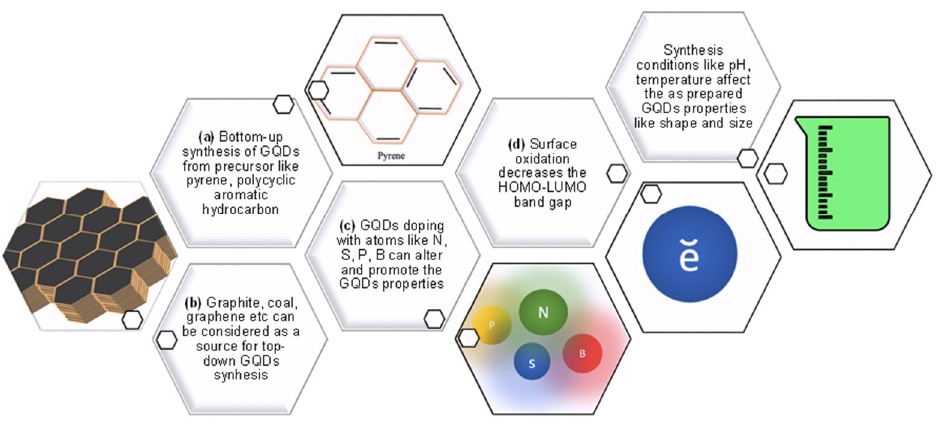
Figure 1. ( a ) Pyrene and polycyclic aromatic hydrocarbon along with other substances can be the precursor required for bottom‐up GQDs synthesis [70,92]. ( b ) Several substances that can be